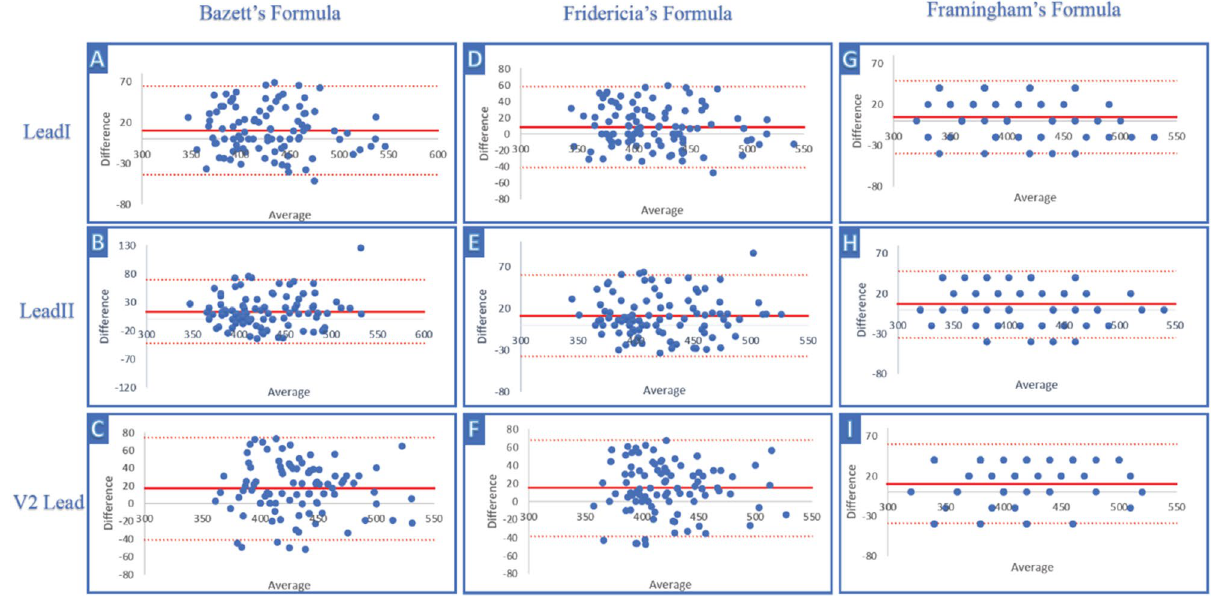
Figure 4. Comparison of QTc mean using Bazett’s, Friedericia’s, and Framingham’s formulas between standard and smartwatch ECG. Bland–Altman plot indicating the level of agreement between the smartwatch ECG and standard 12-lead ECG measurement of QTc (ms) using Bazett’s formula (three panels on the left: ( A – C )); Friedericia’s formula (three panels in the center: ( D – F )); and Framingham’s formula (three panels on the